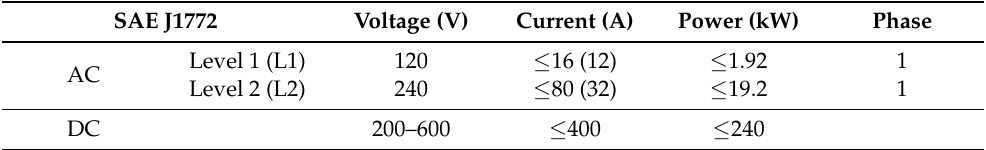
Table 1. EV charging levels based on J1772 of SAE (North America).